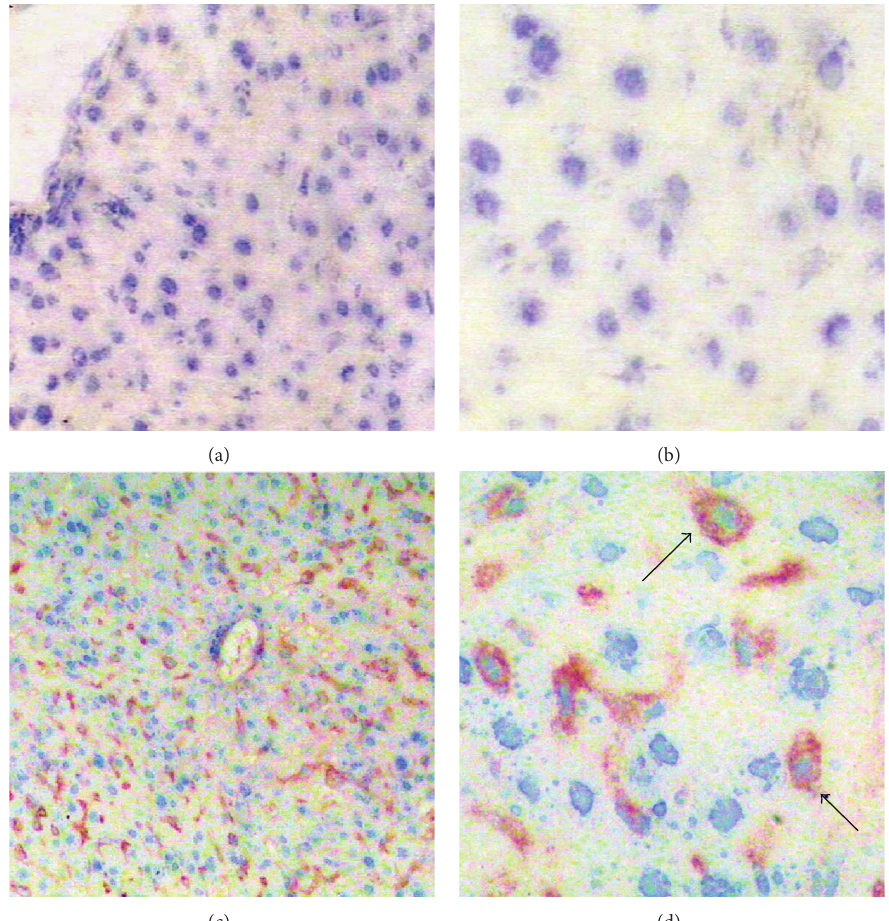
Figure 1: Immunohistochemical staining of liver tissues using anti-PD-L1 Abs. Representative patterns of expression of PD-L1 in liver tissues were shown in sham ((a) and (b)) and CLP mice ((c) and (d)). Positive cells were stained brown. The black arrows indicated PD-L1 + cells. Strong and widespread PD-L1 expression was examined as shown in panel (c) and (d), whereas sham groups showed undetectable signal. Original magnification × 200 for (a) and (c) and × 400 for (b) and